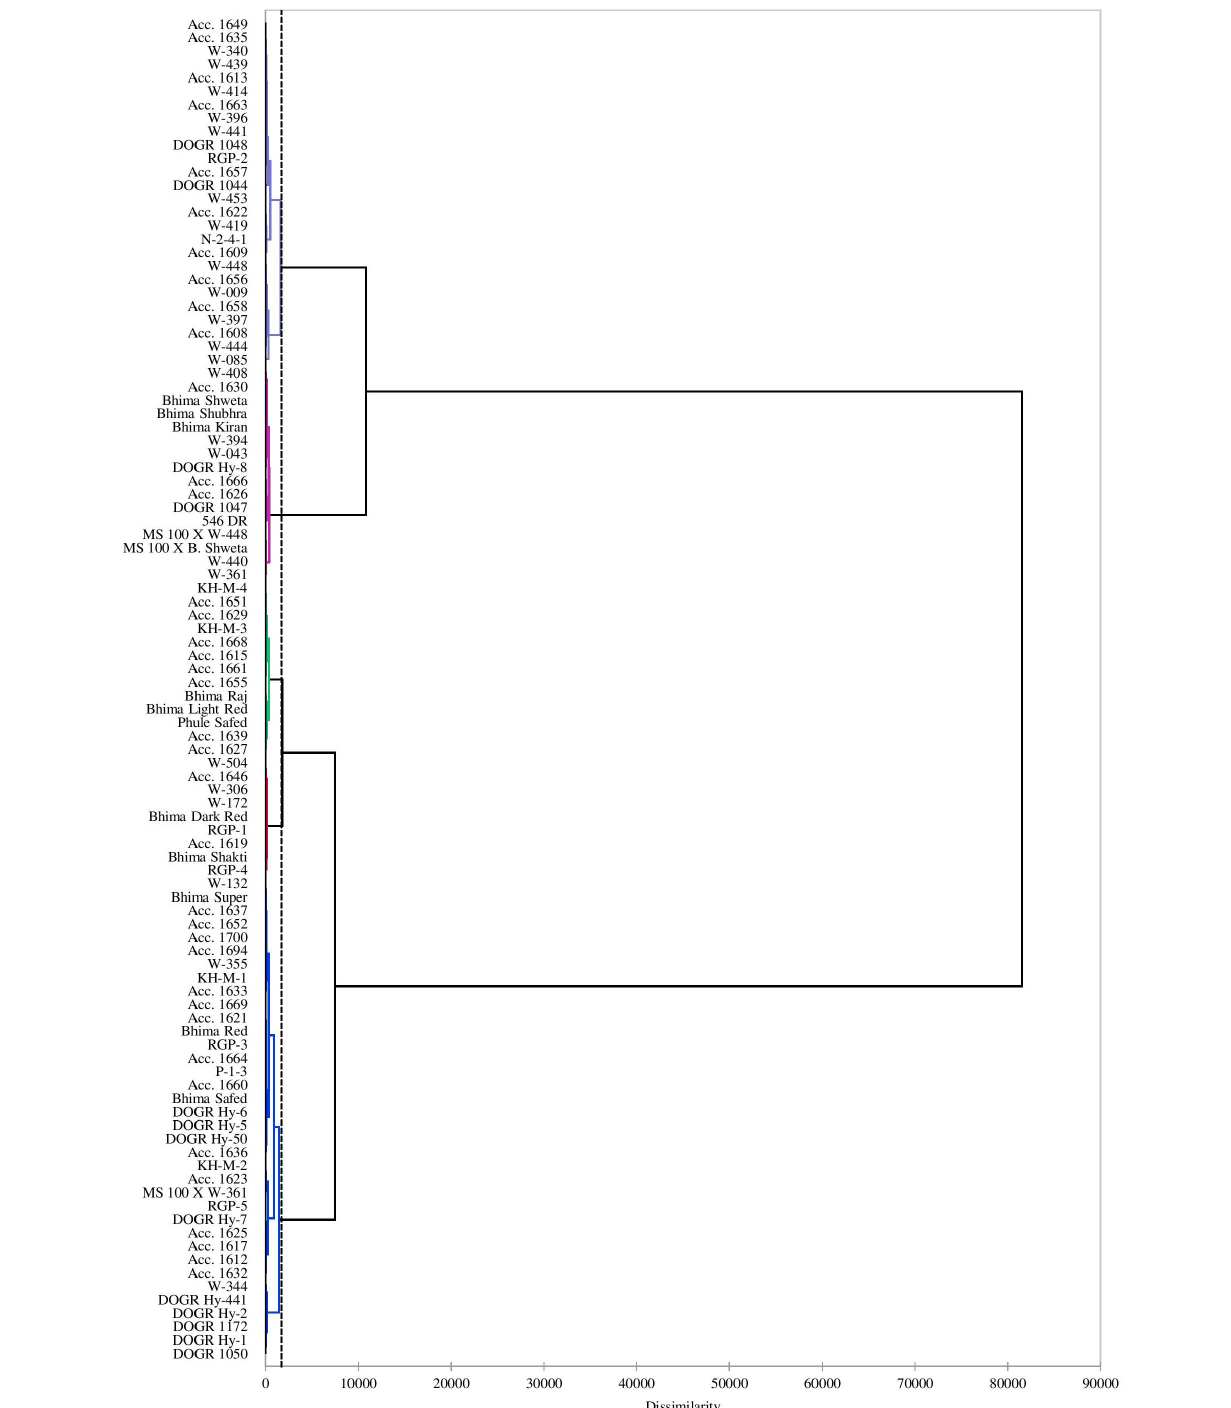
side ofPC1. The PCA thus confirmed that genotypes excelling in drought-adaptive traits namely RWC, MSI, total chlorophyll, antioxidant enzyme activity, and DTE, contributed maximum